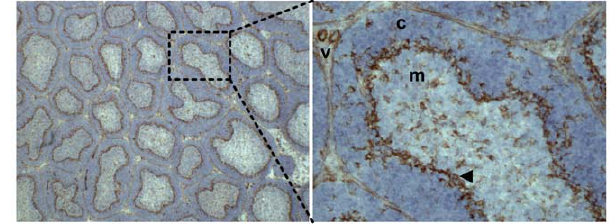
Figure 8. Increased expression of DEC205 on LPS stimulation of adherent spleen cells. The upper two panels show images from two chambers of the same slide, one having been incubated with LPS for one hour (A) and one without (B) The cells were stained with FG9 anti DEC205 antibody (green) and GE8 anti CD83 antibody (red). Nuclei were stained with DAPI (blue). Staining, confocal camera settings and image processing were identical for both images. Surface staining of ungated (C) or cells gated for CD11c expression (D) following stimulation with LPS or CD40 ligand fusion protein are also shown.